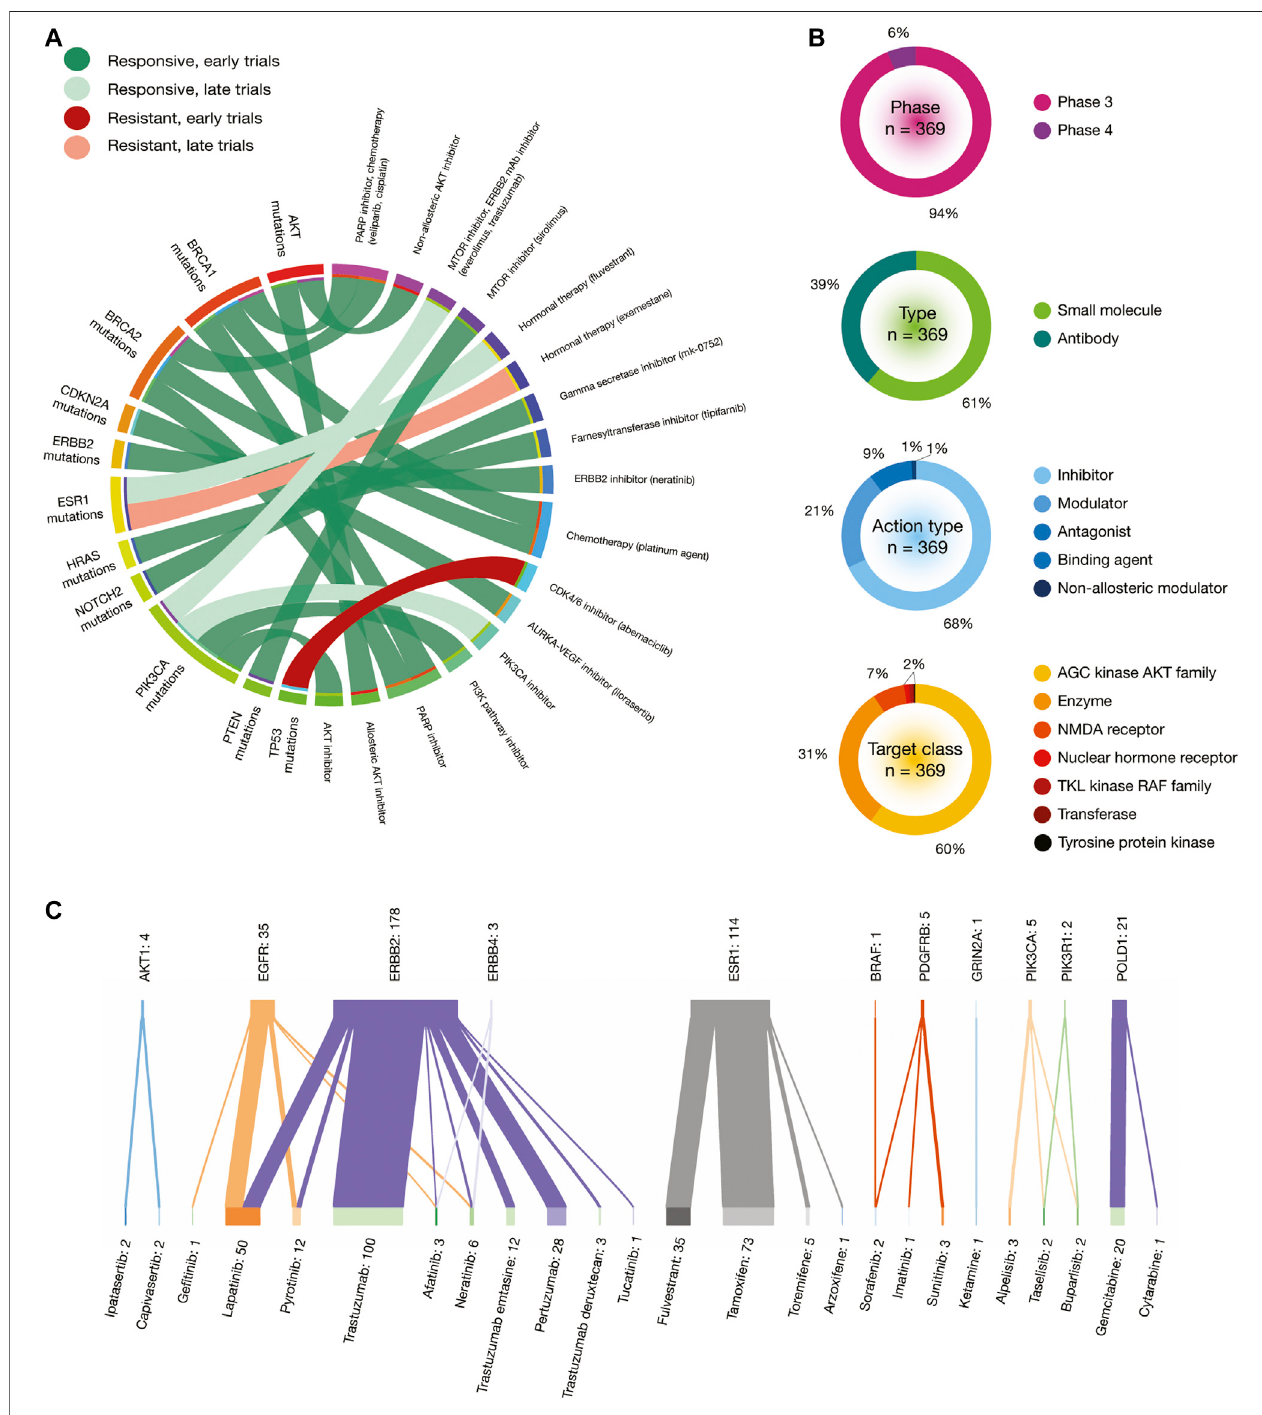
FIGURE8| Insilico drug prescriptions and clinical trials involved in BRCA. (A) Circos plotshowingprecision medicine application between drugs and BRCA driver mutations. (B) Clinical trial features on BRCA. (C) Sankey plot of drugs with the highest number of clinical trials on BRCA driver proteins.